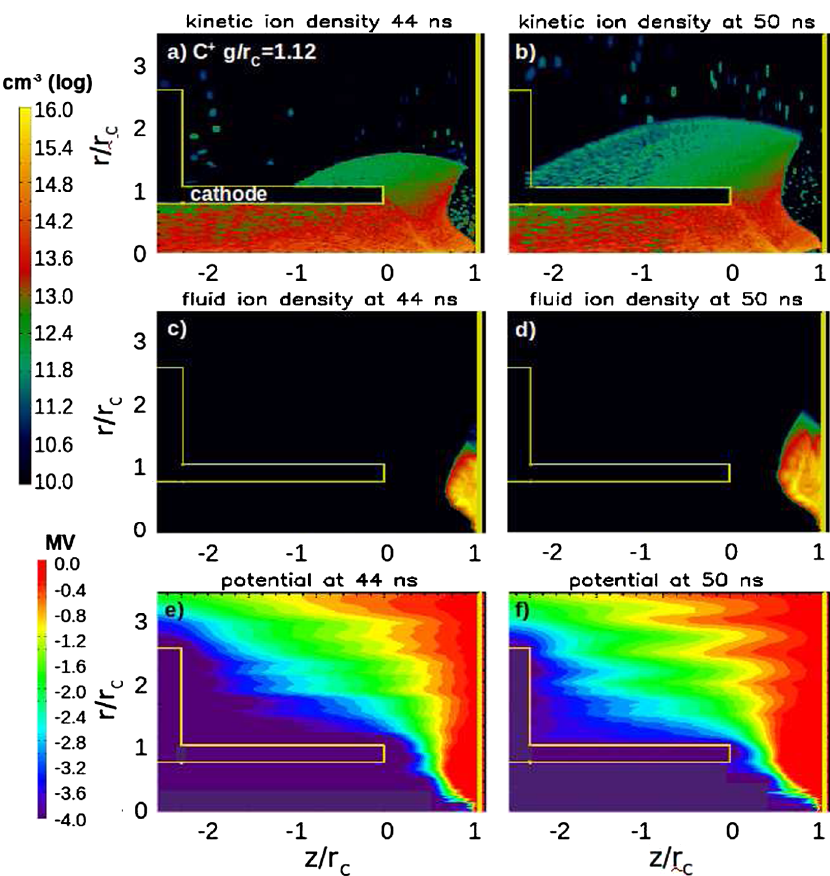
FIG. 5. Snapshots of ion density and electric potential in the SMP diode for a C þ anode plasma. The kinetic ( (cid:5) 200 keV ) ion density is shown in (a) at 44 ns and (b) at 50 ns. The plasma density, approximated by fluid ions, is shown in (c) at 44 ns and (d) at 50 ns. The potential is shown in (e) at 44 ns and (f) at 50 ns. The density contours are plotted on a log is plotted on a linear scale from 0 to (cid:1) 4 MV